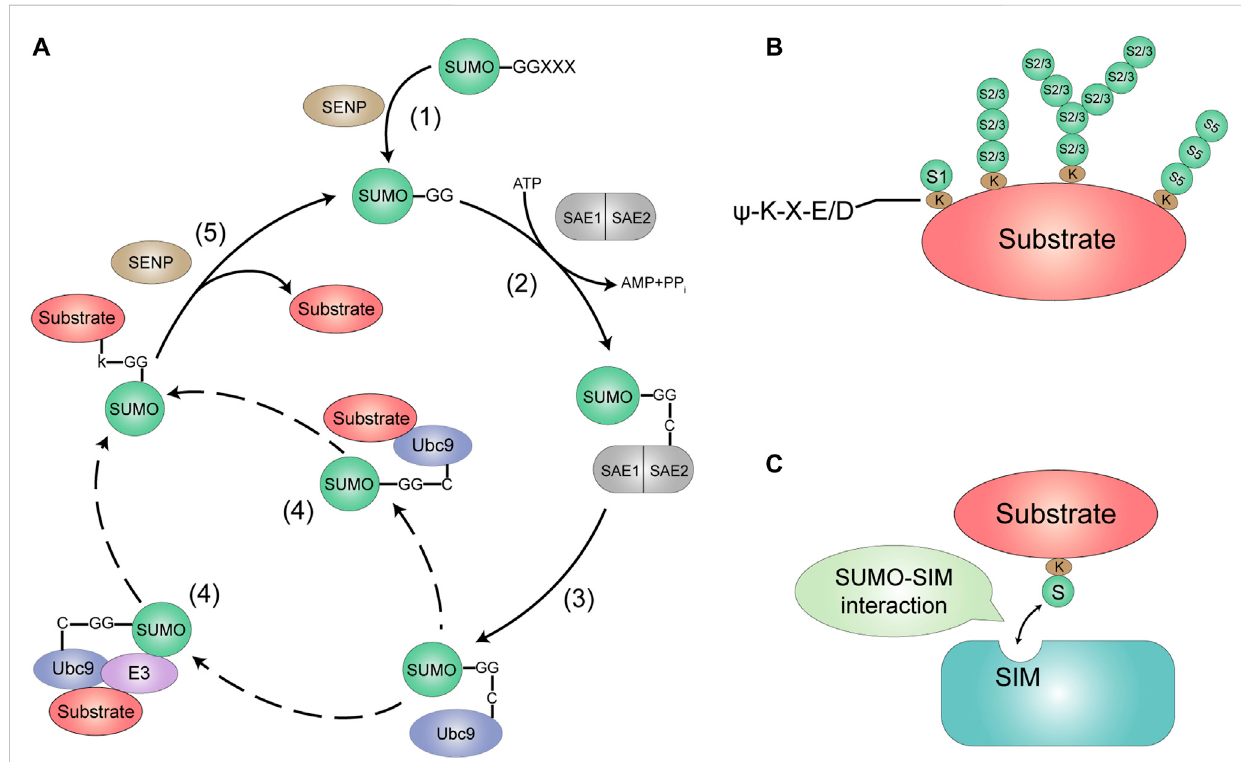
FIGURE 1 The SUMOylation system. (A) SUMO is encoded as an inactive precursor that is cleaved by members of the SENP family to expose the C-terminal diglycine motif (1). This mature form of SUMO is then activated by forming an ATP-dependent thioesler bond with the active site of the Et enzyme (a heterodimer of SAE1 and SAE2) (2). The activated SUMO is then delivered to the active site cysteine of the E2-conjugating enzyme Ubc9. Which then catalyzes the transfer of SUMO to the target protein, either alone or with the help of a SUMO E3 ligase (3, 4). SUMOylated sub-strates show phenotypic differences from the unmodi fi ed form. DeSUMOylation is mediated by the SENP protease family (5). This process releases unmodi fi ed target protein (not shown) and mature SUMO. which can then be used for further binding to the target protein. (B) SUMO modi fi cations most commonly target proteins with the consensus motif w-K-X-FJD. to is a hydrophobic amino acid. K is the target Lys. X is any amino acid, and DIE is Asp or Glu. (cid:129) SUMO chains. (C) Proteins contain-ing SIMs mediate non- SUM01 modi fi es substrates into monomers. While SUMO2/315 modi fi es substrates in poly covalent interactions with